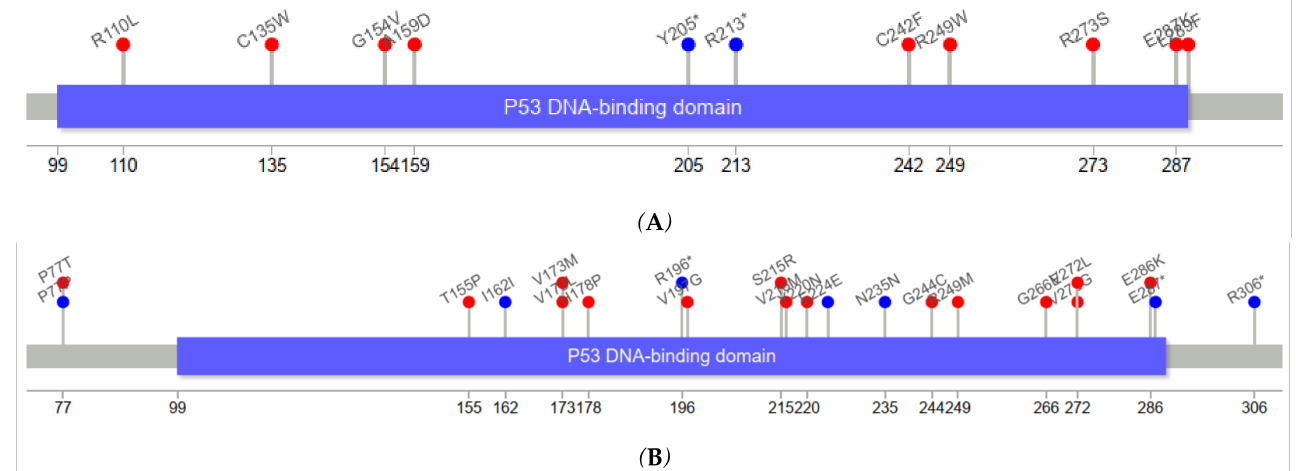
Figure 3. Visualization of mutation (mutations that have no record for protein data not included) [16] ( A ) TP53 variants detected in cfDNA of ESCC cases concordant with a mutation in tumor tissue (R110L, C135W, G154V, A159D, Y205*, R213*, C242F, R249W, R273S, E287K, L289F) ( B ) TP53 variants in tumor tissues not detected in cfDNAs of ESCC cases (P77T, P77P, T155P, I162I, V173M, V173L, H178P, R196*, V197G, S215R, V216M, Y220N, E224E, N235N, G244C, R249M, G266E, V272L, V272G, E286K, E287*, R306*) Supplementary Tables S1 and S2 contain the observed mutations in cfDNA and tumor tissues. Nonsynonymous mutations (red circle), synonymous mutation (blue circle).